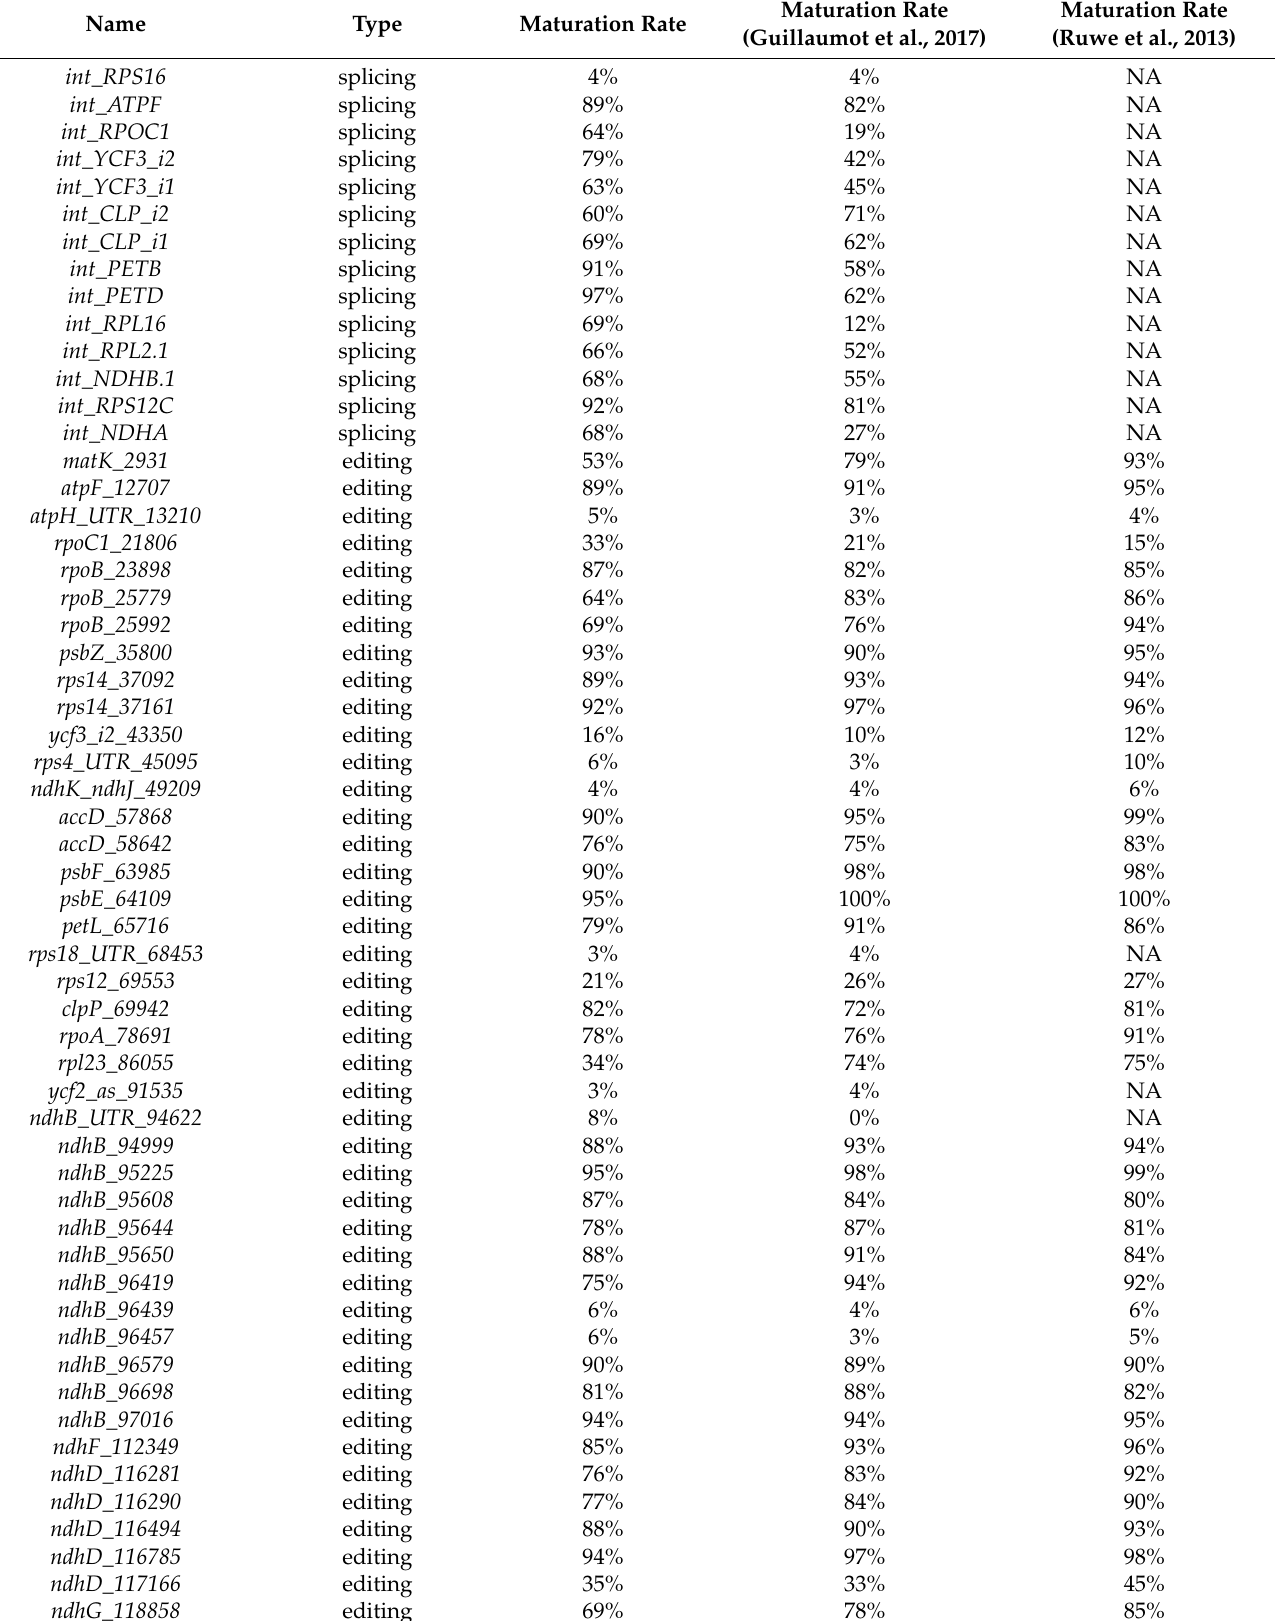
Table 1. Quantification of known editing and splicing